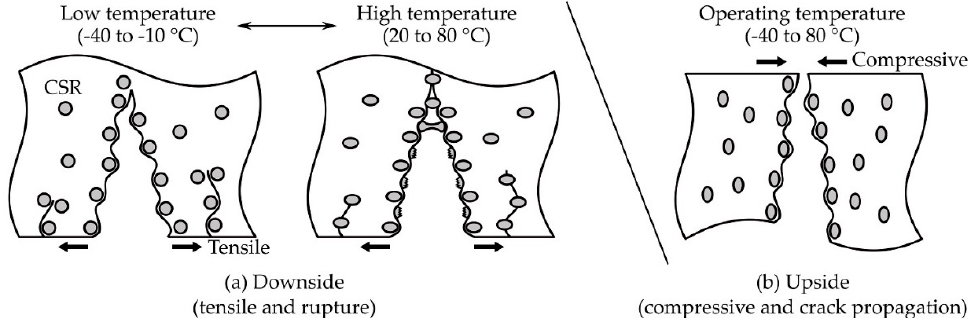
Figure 8. Schematic illustration of the rupture and crack propagation mechanism on the bulk adhesive with CSR content in the three-point flexural test. ( a ) Downside and ( b ) upside surfaces.